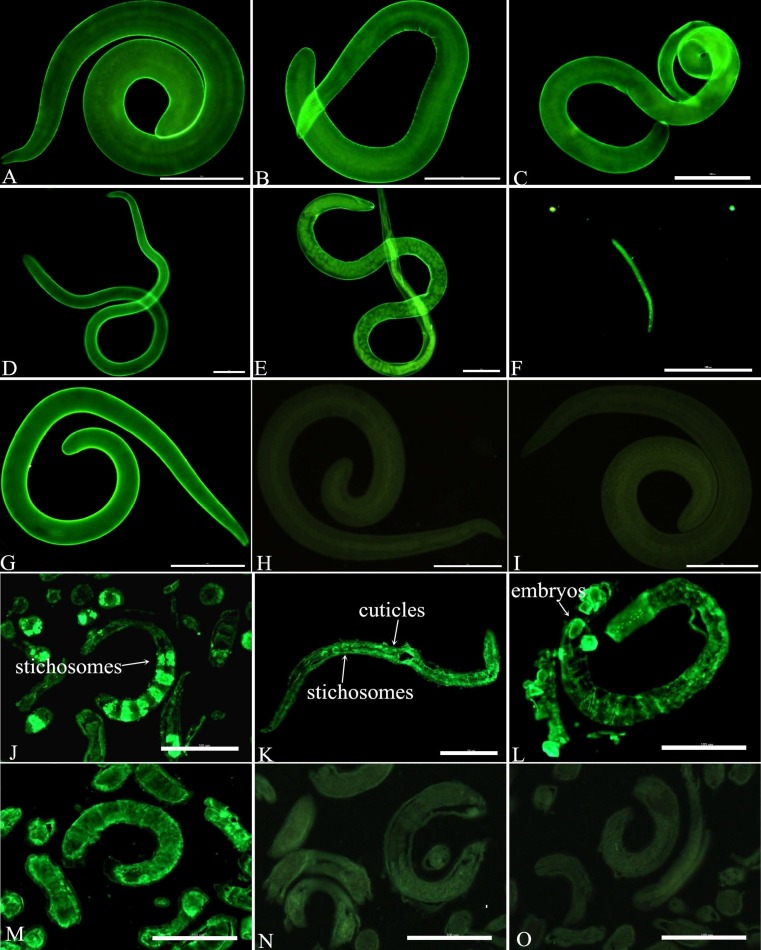
Immunolocalization of TsSP at different T. spiralis phases.A-I: IFT with intact worm of different T. spiralis phases probed by anti-rTsSP serum. The apparent immunostaining is observed on cuticles of ML (A), 6 hpi IIL (B), 24 hpi IIL (C), 3 dpi female adult (D), 6 dpi female adult (E), and NBL (F). The ML probed by infection serum (G) was utilized as a positive serum control; the ML incubated with normal mouse serum (H) and PBS (I) were applied to negative controls. When worm sections were incubated by anti-rTsSP serum, positive staining is seen in cuticles and stichosomes of ML (J), IIL (K) and female adult at 3 dpi (L). The ML probed by infection serum (M) was employed as a positive serum control; ML reveals no staining with normal mouse serum (N) and PBS (O) as a negative control. Scale-bars: 100 μm.